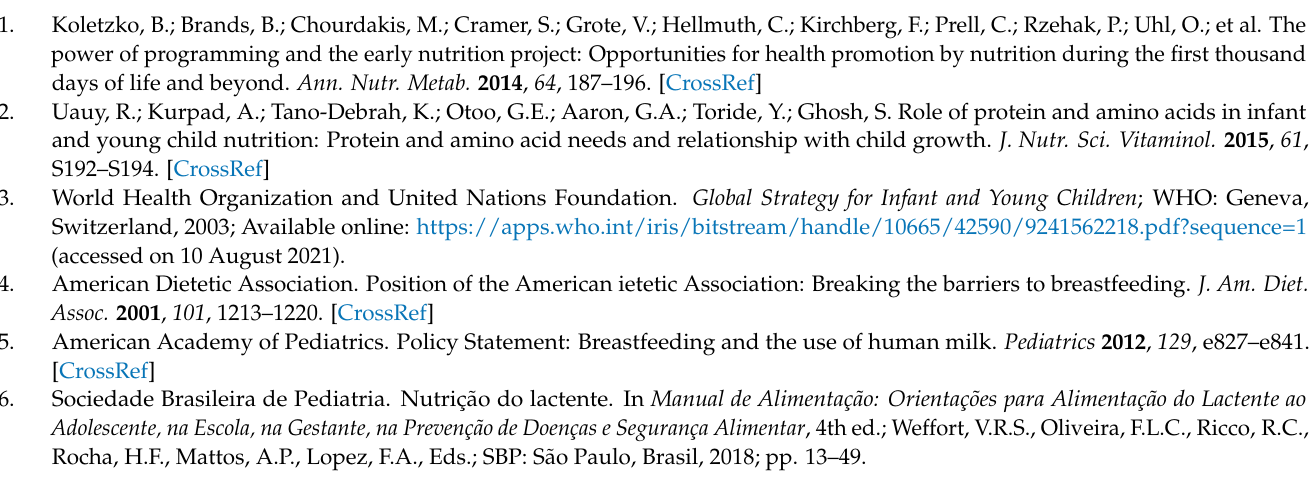
.3390/nu13113933/s1, Table S1: Coded infant formulas. Table S2: Protein label content vs. determined crude protein in different infant formulas (IFs). Figure S3: Representative chromatogram of a mixture of bovine milk proteins and lactoferrin standards (A) and a protein fraction chromatogram from infant formulas (B). Figure S4: Standard curves of bovine milk protein fractions identified by